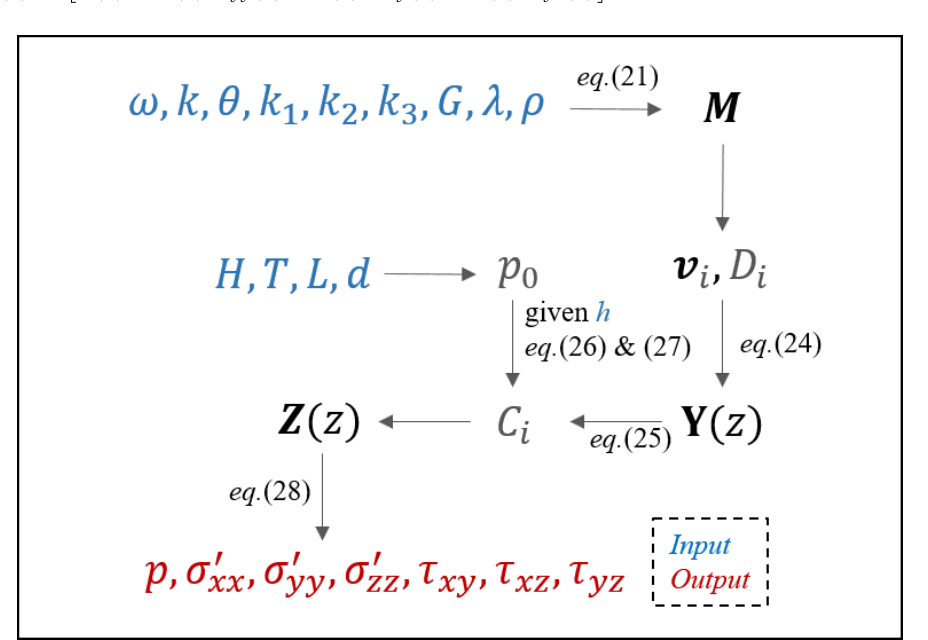
Figure 1. Schematic diagram of the steps in the implementation